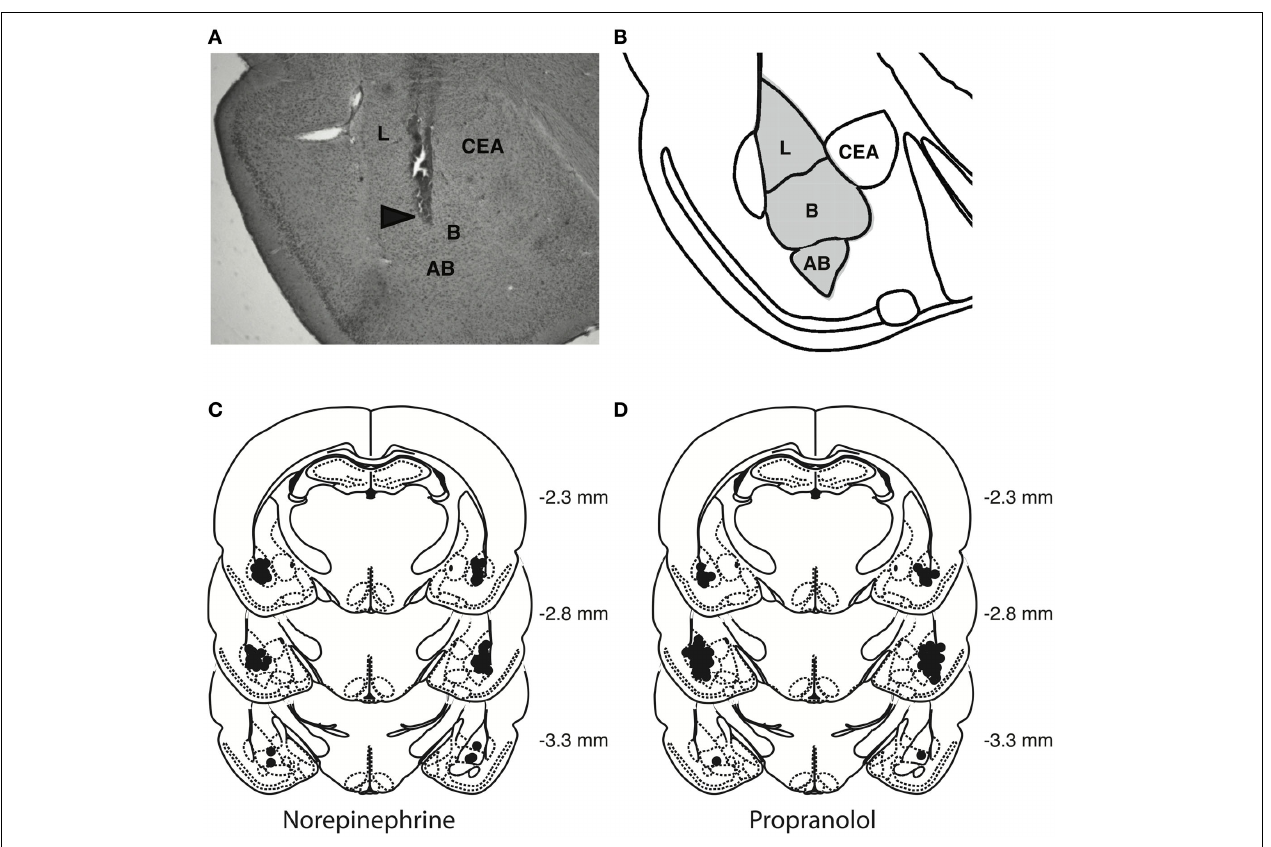
FIGURE 2 | Histological analyses. (A) Representative photomicrograph illustrating placement of a cannula and needle tip in the BLA. Arrow points to needle tip. (B) The gray area in the diagram represents the different nuclei of